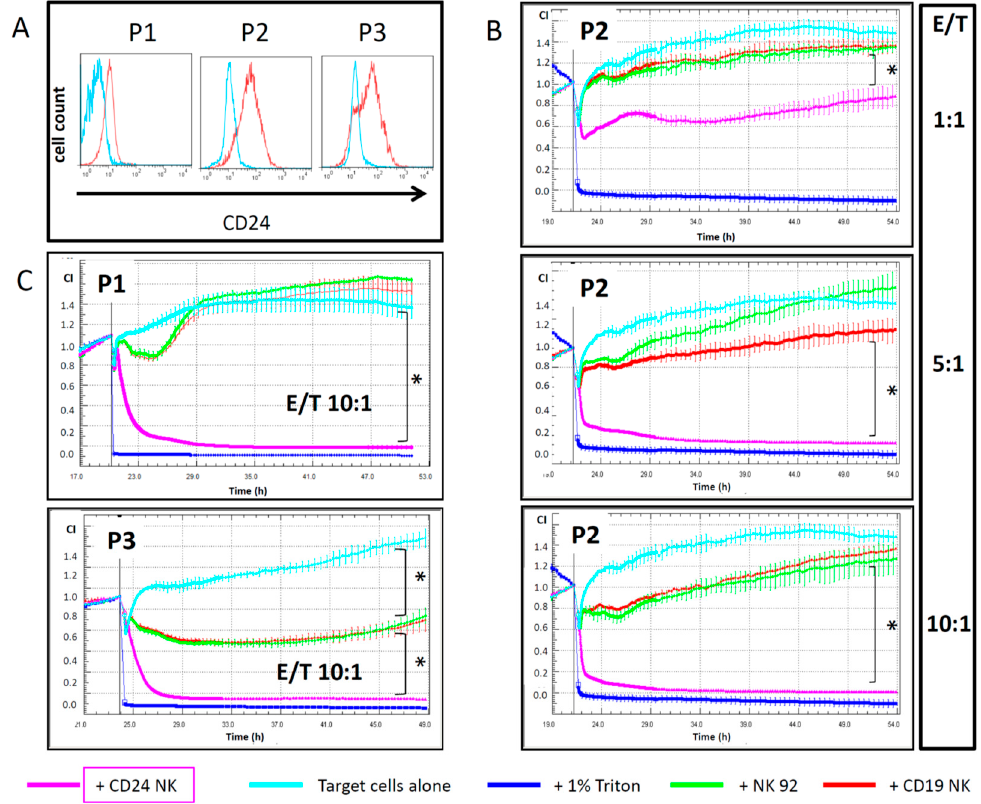
Figure 3. Anti-CD24-CAR-NK-92 cells exhibit strong killing activity against primary OC cells. ( A ) Flow cytometric quantification of CD24 expression in three different primary ovarian cancer cell samples. These cells were harvested from consecutive ascites samples from one patient before (P1) or during chemotherapy (P2 and P3). ( B ) Cytotoxic effects of engineered NK-92 cells in primary ovarian cancer cells (P2) as measured by xCELLigence. Per well, 1 × 10 4 primary OC cells were seeded. E/T indicates the specific effector/target cell ratios. ( C ) xCELLigence results for P1 and P3 cells at an E/T ratio of 10:1. Values represent the mean from two separate experiments, each containing three samples. * indicate p -values < 0.01 for the 10 h time point